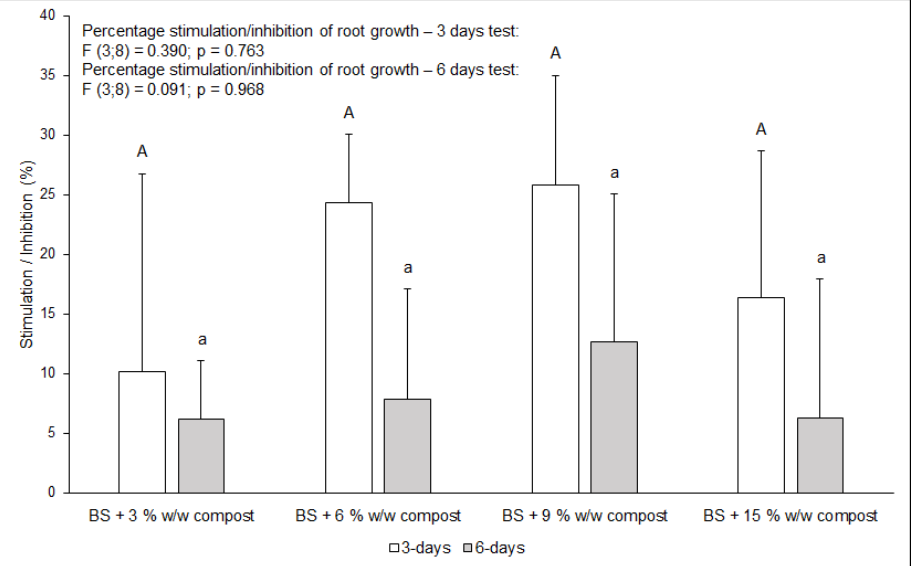
Figure 8. Comparison of inhibition/stimulation of root growth of Lepidium Sativum L. after 3 and 6 days of exposure to burnt soil supplemented with compost in increasing proportions (compared to burnt soil). Average values (n = 3) + SE are presented, different uppercase letters indicate significant differences between individual variants after 3 days of testing and small letters after 6 days (one-way ANOVA with post hoc Tukey’s HSD test). The results of the F test are shown at the top of the graph.